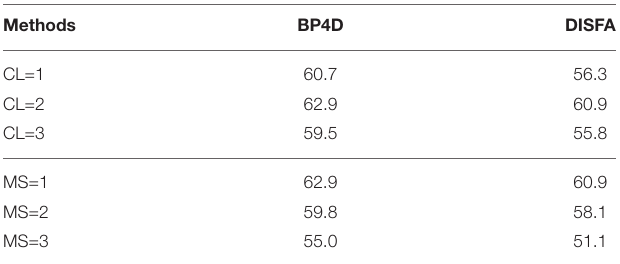
TABLE 3 | Ablation studies on the BP4D and DISFA datasets. Methods BP4D DISFA